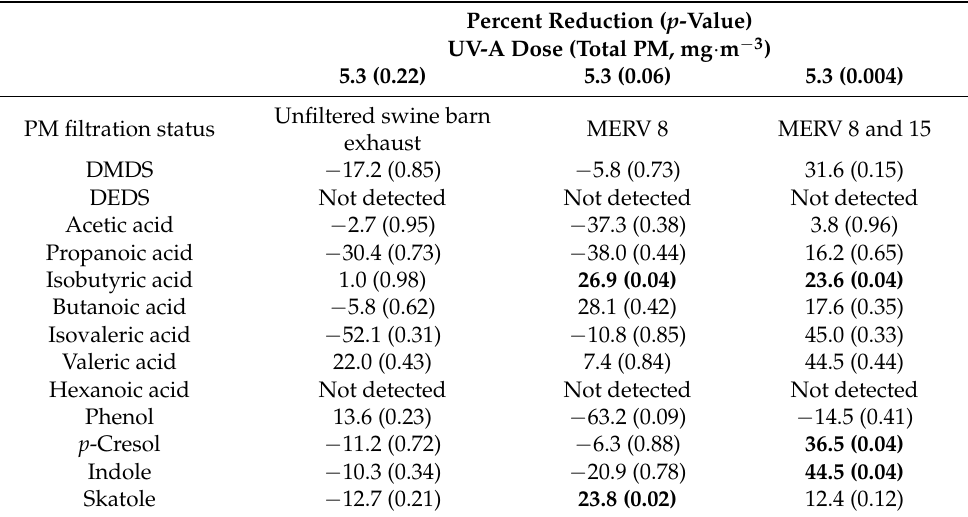
Table 11. Performance of UV-A photocatalysis in mitigating odorous VOCs under different PM